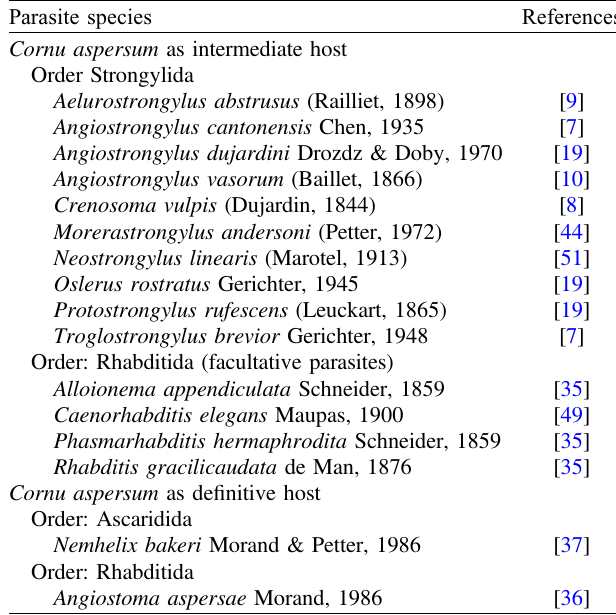
Table 1. Nematode species parasitizing Cornu aspersum as intermediate or de fi nitive